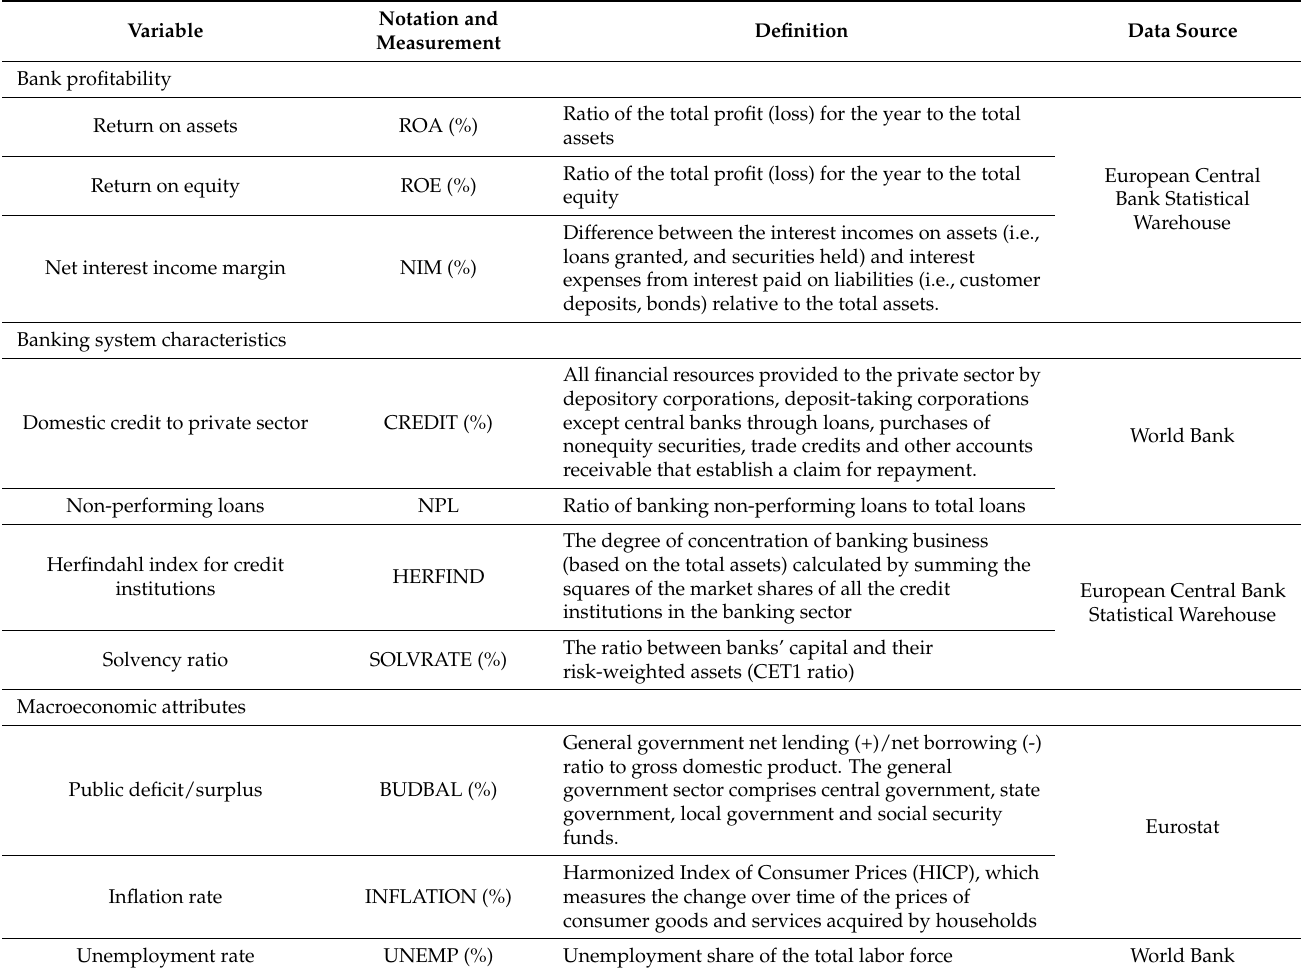
Table 1. Description of